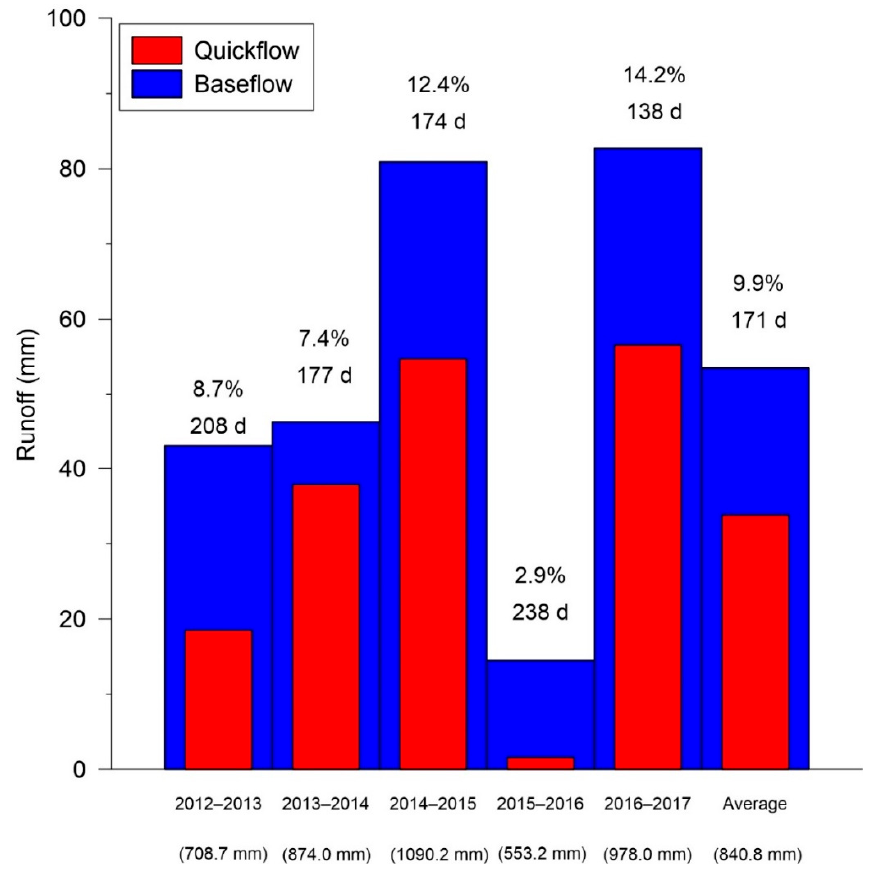
Figure 4. Baseflow and quickflow contributions (mm) in the total flow for each hydrological year (October to September) at Es Fangar Creek. The annual R c is depicted in %, as well as the total number of days (d) with recorded flow at the gauging station. The total annual rainfall is also illustrated in brackets.